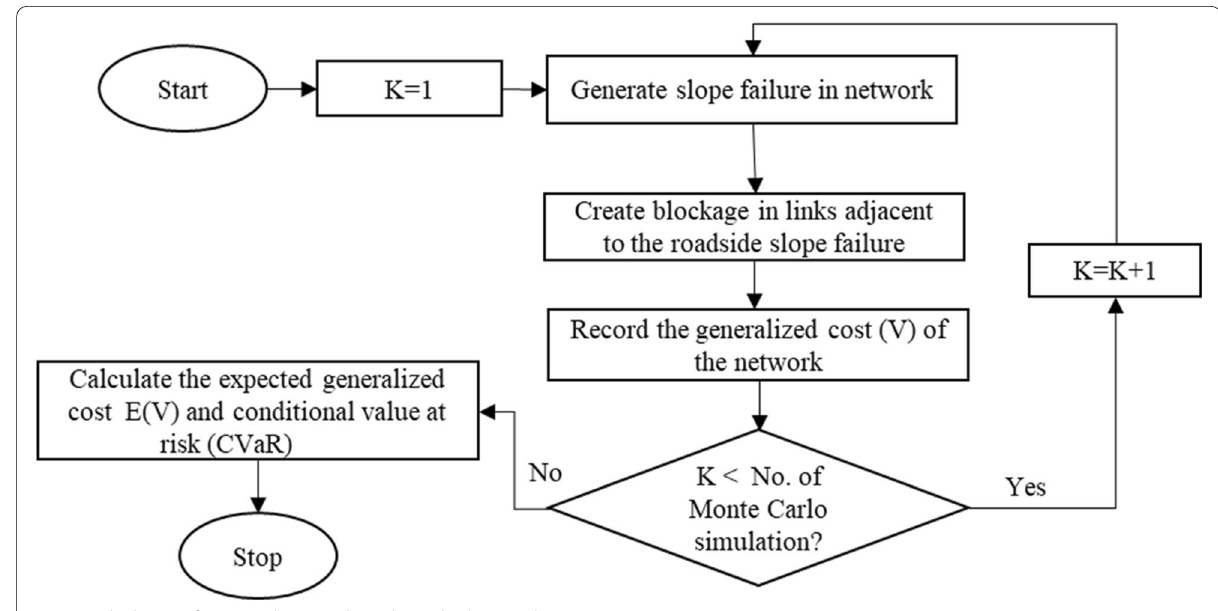
Fig. 4 Calculation of expected cost and conditional value at